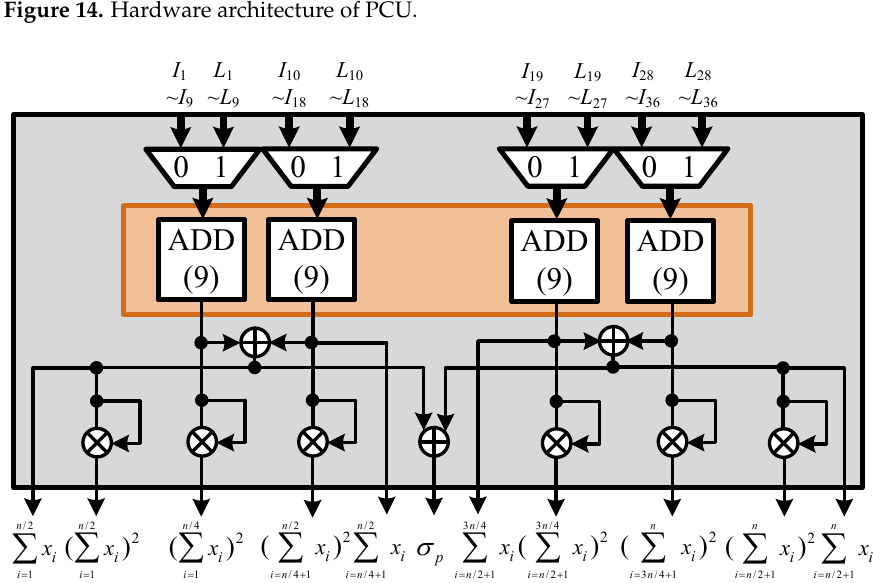
Figure 14. Hardware architecture of PCU.